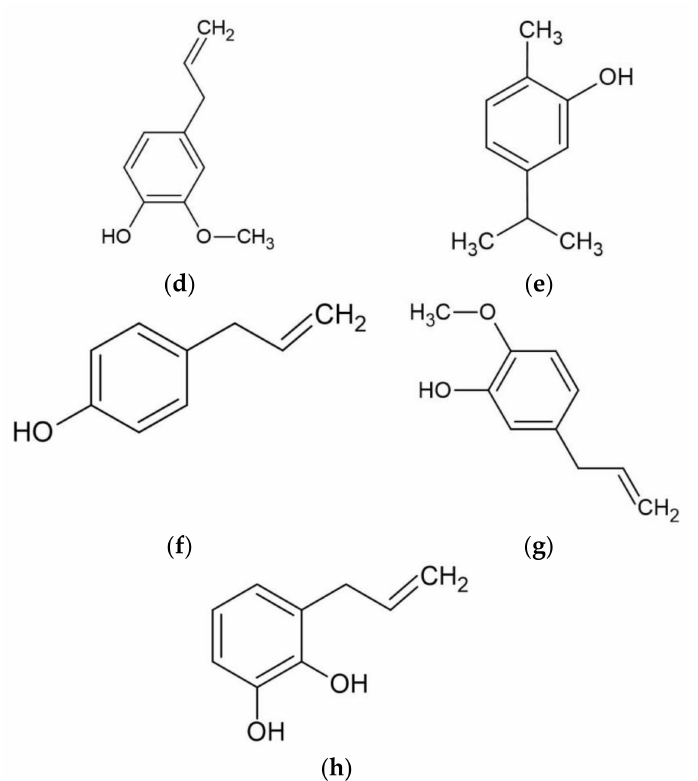
Figure 1. Major bioactive compounds in betel leaves extracts and essential oil. ( a ) phytol; ( b ) 4- chromanol; ( c ) hydroxychavicol; ( d ) eugenol; ( e ) carvacrol; ( f ) chavicol; ( g ) chavibetol; ( h ) allylpyro- catechols